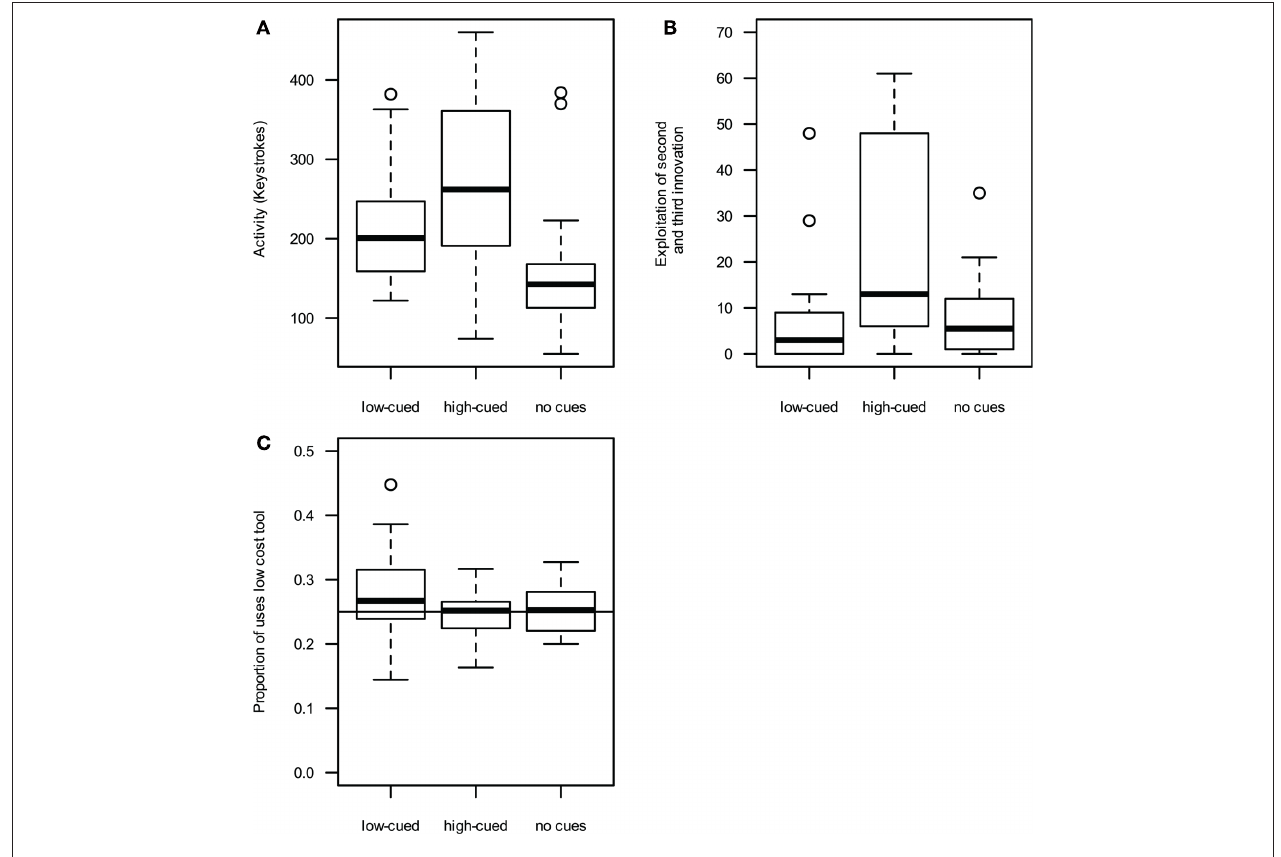
denoting the 1.5 interquartile range and points